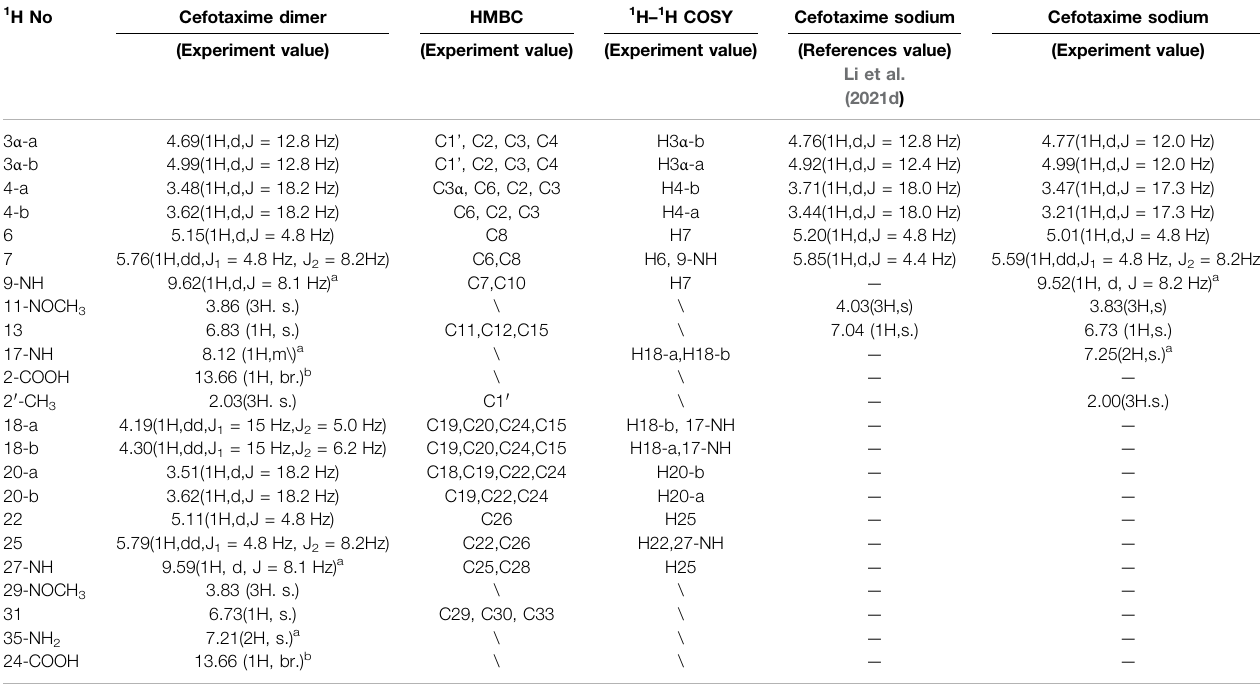
TABLE 2 | 1 H-NMR and 2D-NMR spectra of cefotaxime and cefotaxime